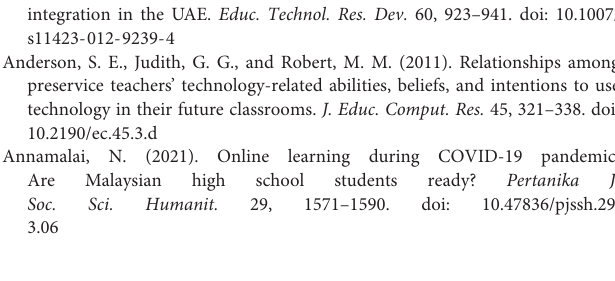
the emerging themes in each